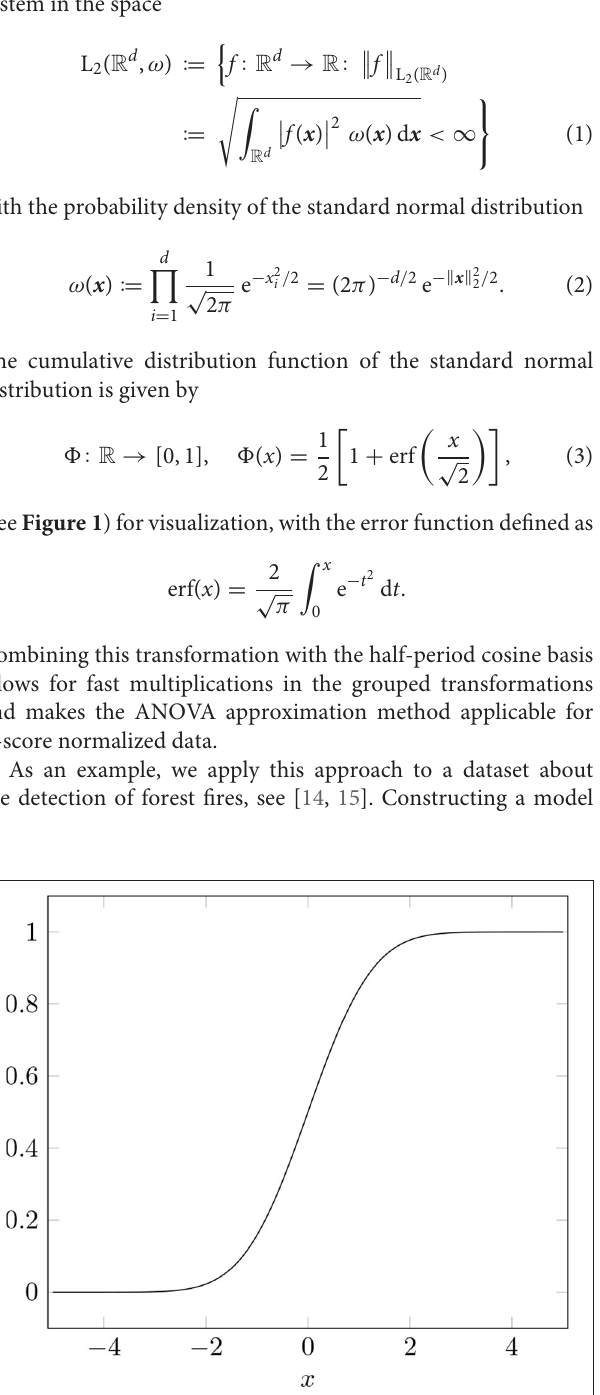
FIGURE 1 | Cumulative distribution function 8 of the standard normal distribution from Equation